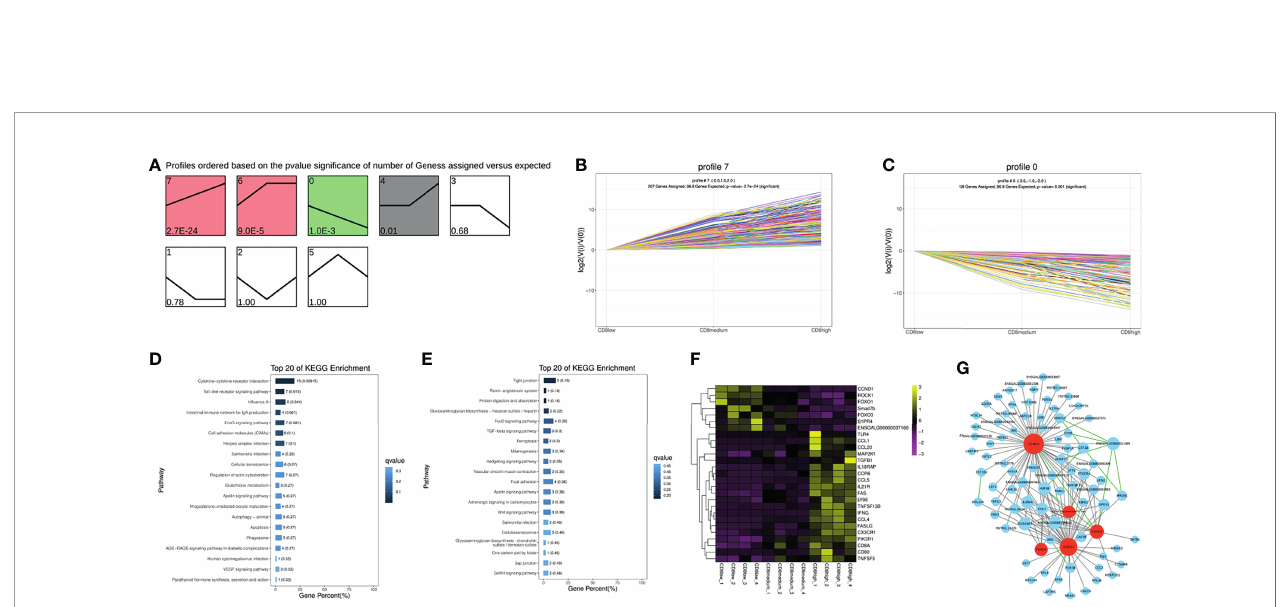
FIGURE 3 | Trend analysis of CD4 + CD8 low+ , CD8 medium+ and CD8 high+ T cells. (A) All differentially expressed genes (DEGs) expression pro fi les were ordered based on the P -values of CD4 + CD8 low+ , CD8 medium+, and CD8 high+ T cells. (B) The DEGs expression trends in pro fi le 7. (C) The DEGs expression trends in pro fi le 0. (D) Top 20 KEGG pathways were selected for pro fi le 7 DEGs enrichment. (E) Top 20 KEGG pathways were selected for pro fi le 0 DEGs enrichment. (F) Heat map of picked-up immune genes. (G) Gene interaction network analysis based on the WGCNA analysis and STRING database. The gray line indicates the interaction relationship based on the WGCNA analysis. The green line indicates the potential interaction based on the STRING database. Red nodes represent hub